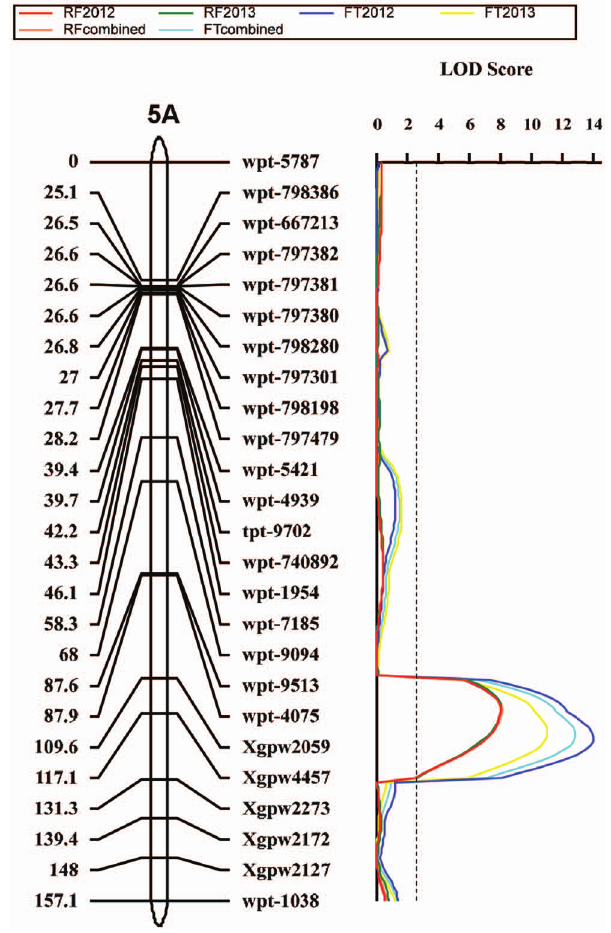
Figure 6. Quantitative trait loci (QTL) for brittle rachis and threshability. QTL detected on chromosome 5A in the Triticum aestivum ssp. tibetanum Shao population from accessions Q1028 6 ZM9023. Marker positions are shown on the right of the linkage map, and distances between loci (in centimorgans, cM) are shown on the left. The vertical dashed line indicates the significance threshold (LOD 5